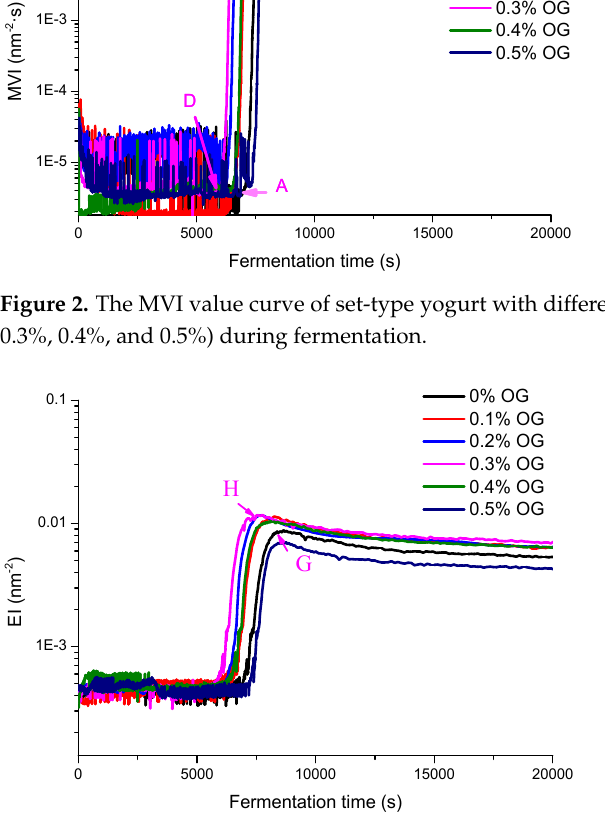
Figure 3. The EI value curve of set-type yogurt with different OG concentrations (0%, 0.1%, 0.2%, 0.3%, 0.4%, and 0.5%) during